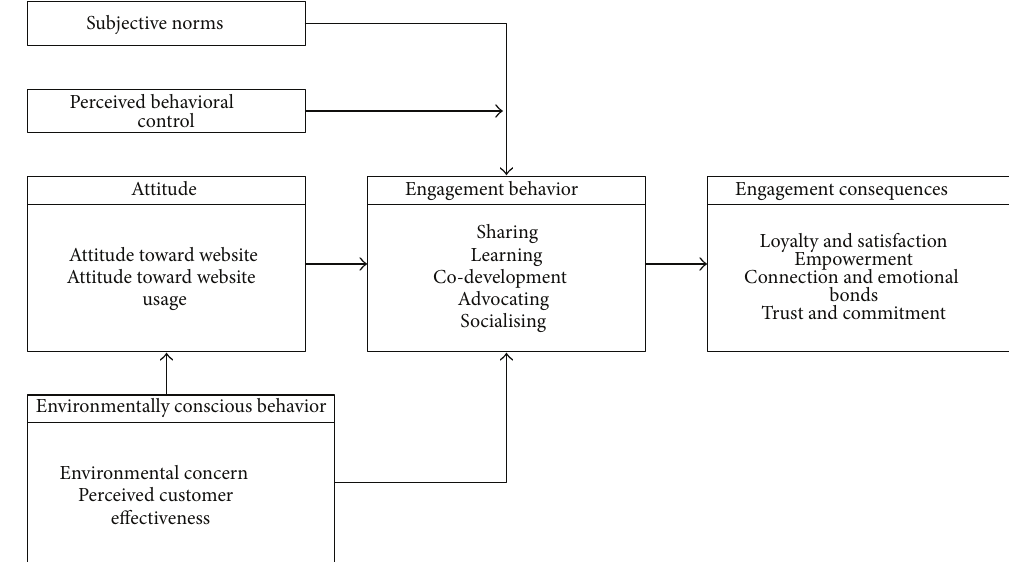
Figure 5: The structure of proposed model 2.